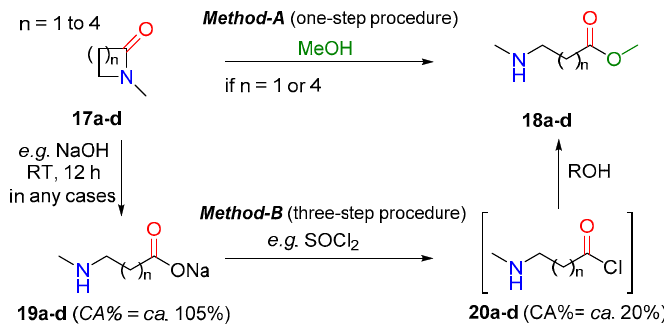
Figure 10. One step (Method-A; top ) and multi-step (Method-B, bottom ) procedures to transform cyclic amide (lactam) with various ring sizes to amino ester (for the corresponding carbonylicity values computed at B3LYP/6-31G(d,p) level of theory; see Table 1). The carbonylicity values for 19 and 20 are average values. Table 1. The calculated carbonylicity values (CA%) of compounds 17a – d and 18a – b and the carbonylicity changes ( Δ CA) for ring-opening alcoholysis depending on the ring size.